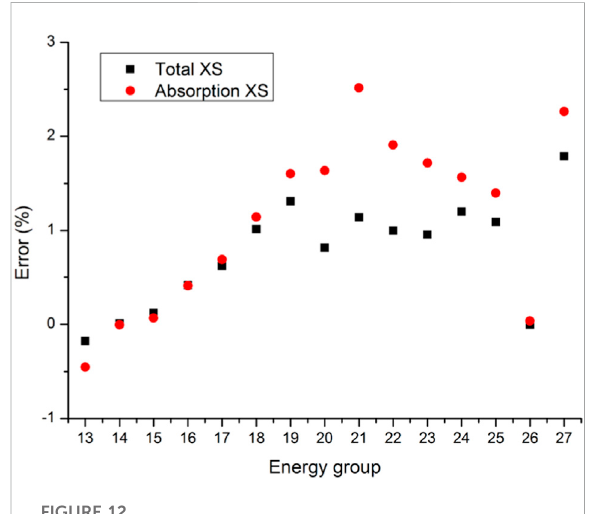
FIGURE 12 Comparison of 238 U total and absorption cross sections in Region 3.